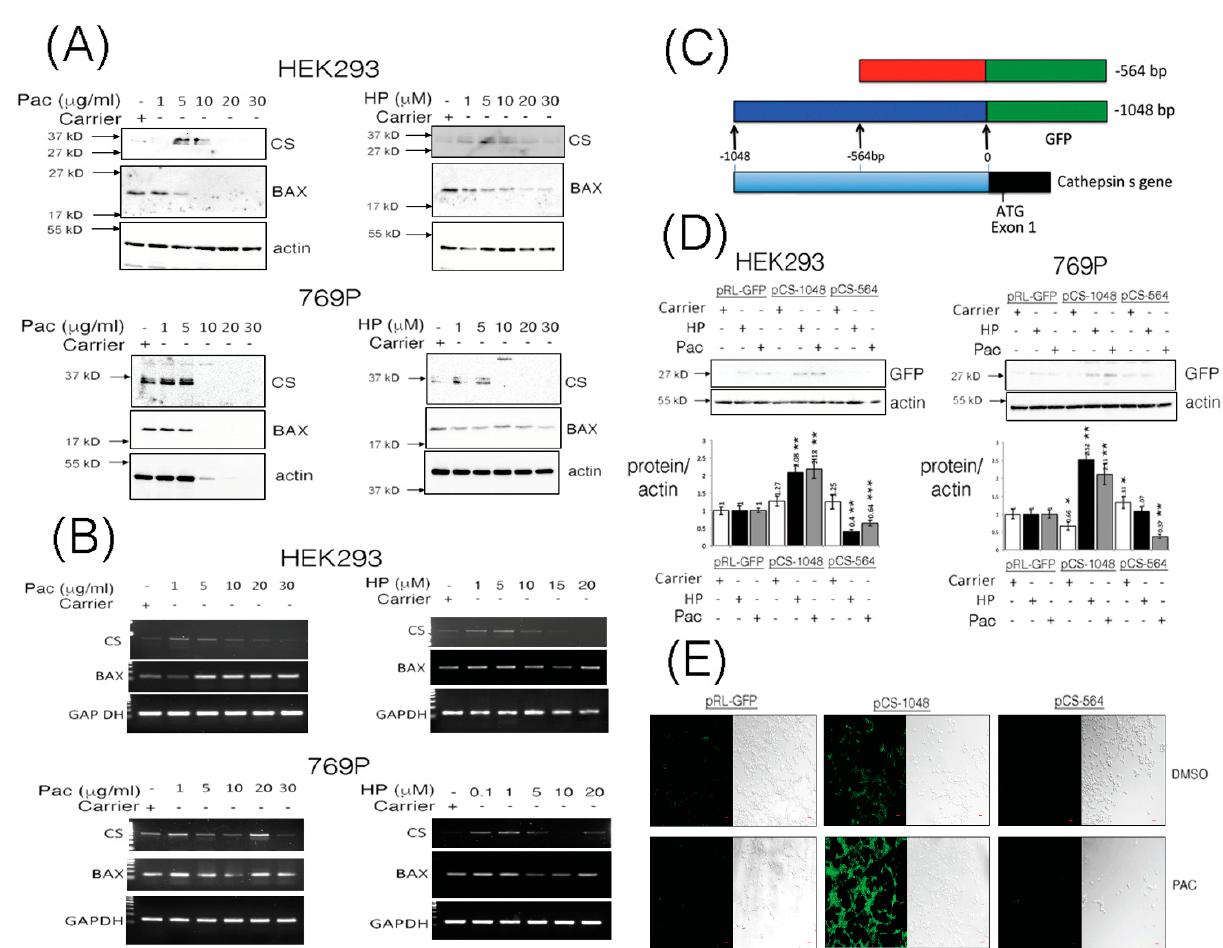
Figure 1. Cathepsin S (CS) protein expression levels are induced through the -1048 promoter fragment from the CTTS gene upon Paclitaxel or hydrogen peroxide stimulation. HEK293 and 769P cells were stimulated with increasing doses of Paclitaxel (Pac) and hydrogen peroxide (HP) and soluble lysates prepared after 24 h and equal volumes analyzed by Western blotting for cathepsin S (CS), BAX and actin expression (Panel A ). Similarly, total RNA was isolated from cells stimulated for 24 h with increasing doses of Pac or HP and equal quantities of template cDNA analyzed for transcriptional expression of CS, BAX and Glyceraldehyde-3-phosphate dehydrogenase (GAP-DH, Panel B ). Promoter fragments, derived from the transcriptional start site of the CTTS gene to -1048 and -564, were PCR cloned and fused to a promoter-less GFP encoding plasmid (Panel C ) and evaluated for GFP expression in equal volumes of HEK293 and 769P cleared whole cell lysates (WCLs) under Pac (10 μ g/mL and 5 μ g/mL, respectively) or HP (5 μ M) stimulatory conditions. GFP expression was also quantified, standardized and corrected against GFP expression from cells stimulated with carrier alone and is shown as a fold change over basal GFP expression (Panel D ). HEK293 cells transfected with pCS-1048 or pCS-564 and stimulated with Pac (5 µ g/mL) for 24 h were also fixed and visualized for GFP expression using laser scanning confocal microscopy (Panel E ). The red bar indicates 1 micron. Quantified data are presented as the mean ± SEM and its significance (where p < 0.05) determined, using a two-way Student’s t -test (* p < 0.05, ** p < 0.01 and *** p <